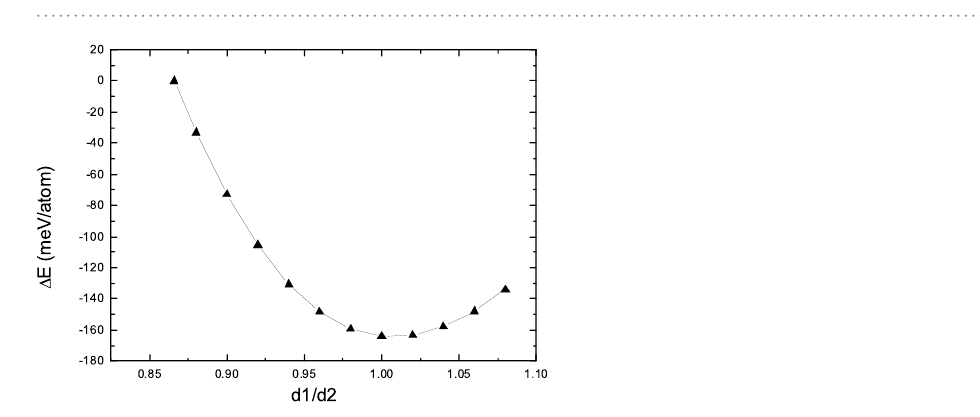
Figure 5. Schematic illustrations of the HCP/FCC interface model of I2 with the unit cell of 4 √ 3 a × a × (8 × 1.583 a ) before volume expansion. The x axis is along < > 1010 and the z axis is along < > 0001 planes, respectively. d1 and d2 are the nearest-neighbor distance in the < > 110 and < > 110 directions, respectively. d3 is the interface spacing between HCP and FCC.